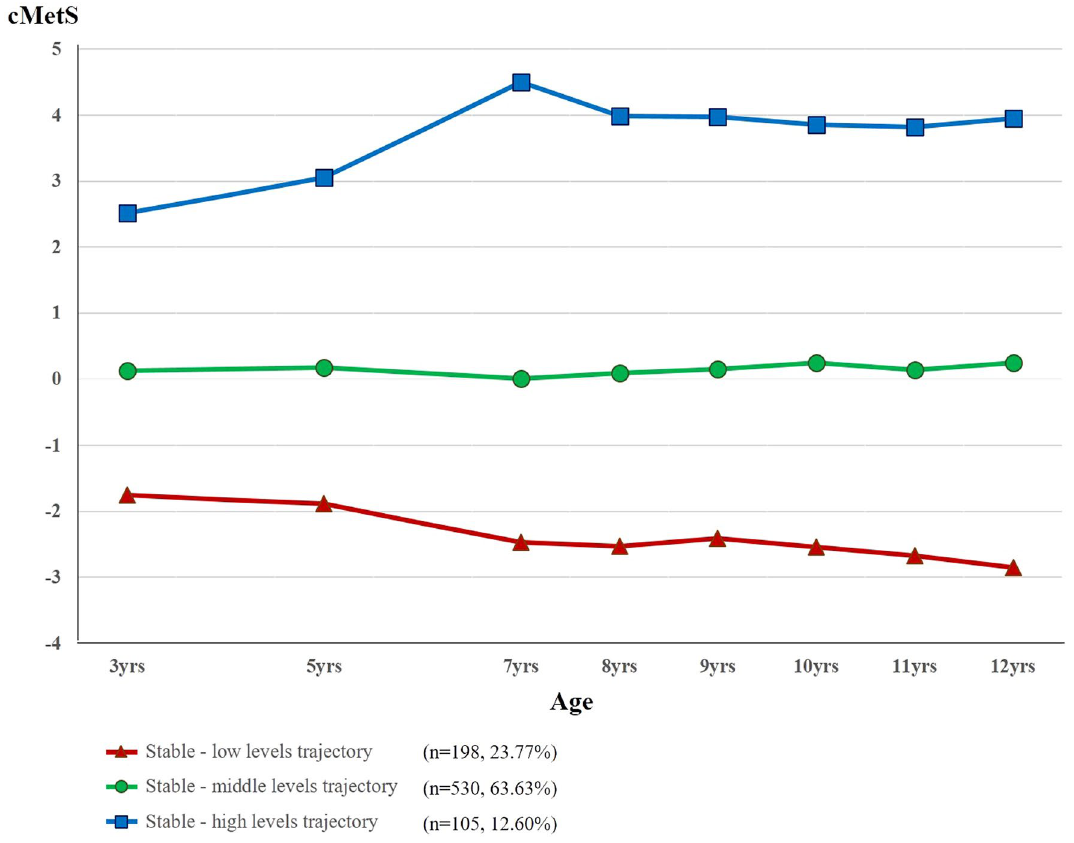
Figure 1. Trajectroies of cMetS from 3 to 12 years of age. Abbreviation: cMetS, continuous metabolic syndrome score.